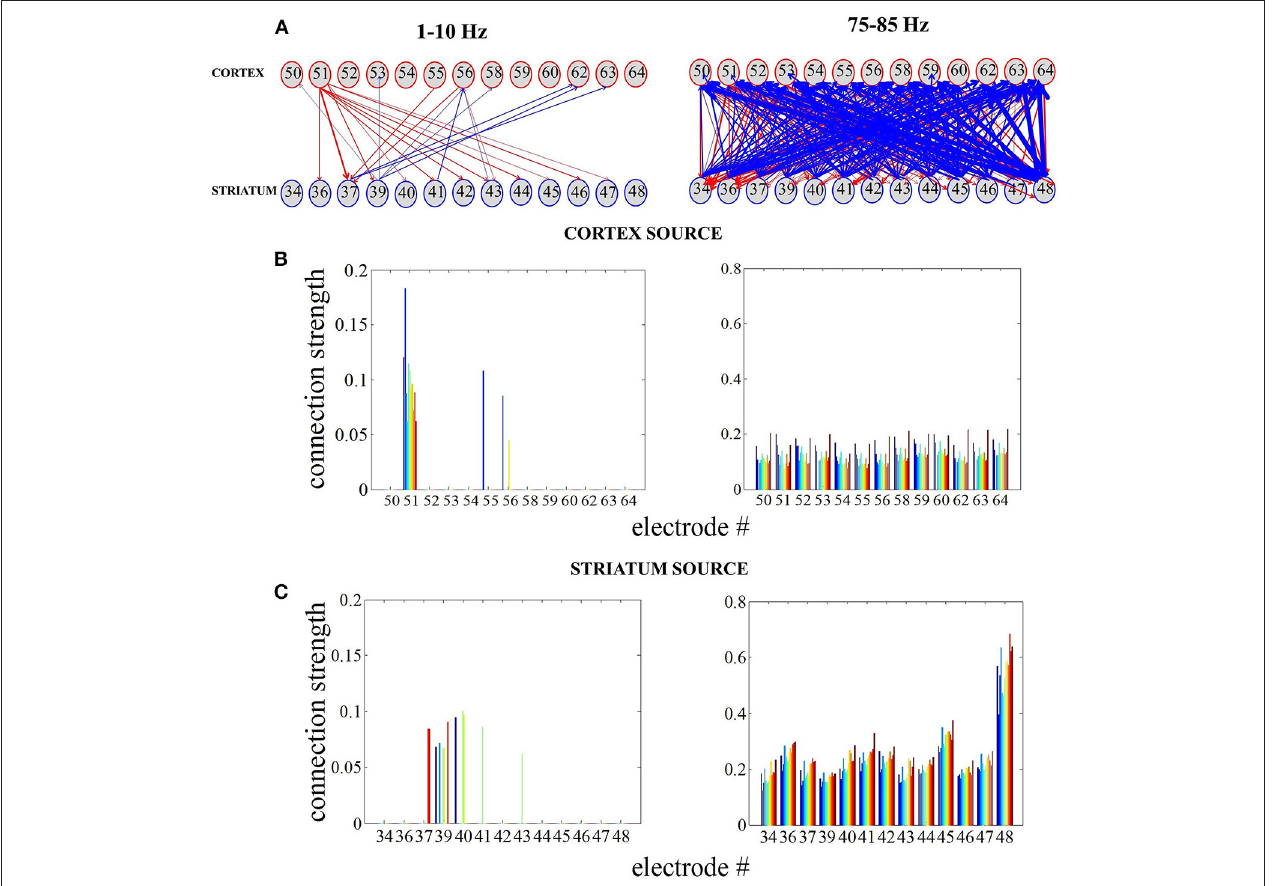
FIGURE 6 | Reconstructing cortico-striatal network topology for frequency ranges 75–85Hz and low frequencies. (A) Directed, weighted architectures of the cortico-striatal network. (B) Cumulative strength of directed connections in the case where the cortex is assumed to be the source. The x-axis corresponds to the cortical electrodes and how they influence the striatal electrodes (different colors denote sink nodes). (C) The same as in (A) in the case where the striatum is assumed to be the source.